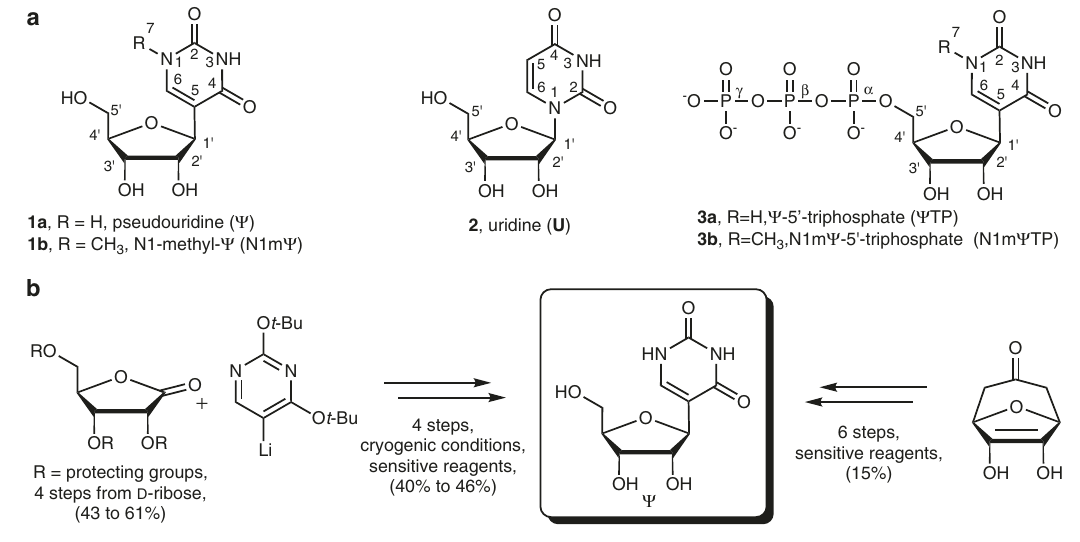
Fig. 1 | Examples of chemical syntheses of Ψ . a The C -nucleosides Ψ and N1m Ψ compared to the N -nucleoside isomer U . Structures of Ψ TP and N1m Ψ TP as the C- nucleotides used for therapeutic mRNA production. b Exemplary synthesis